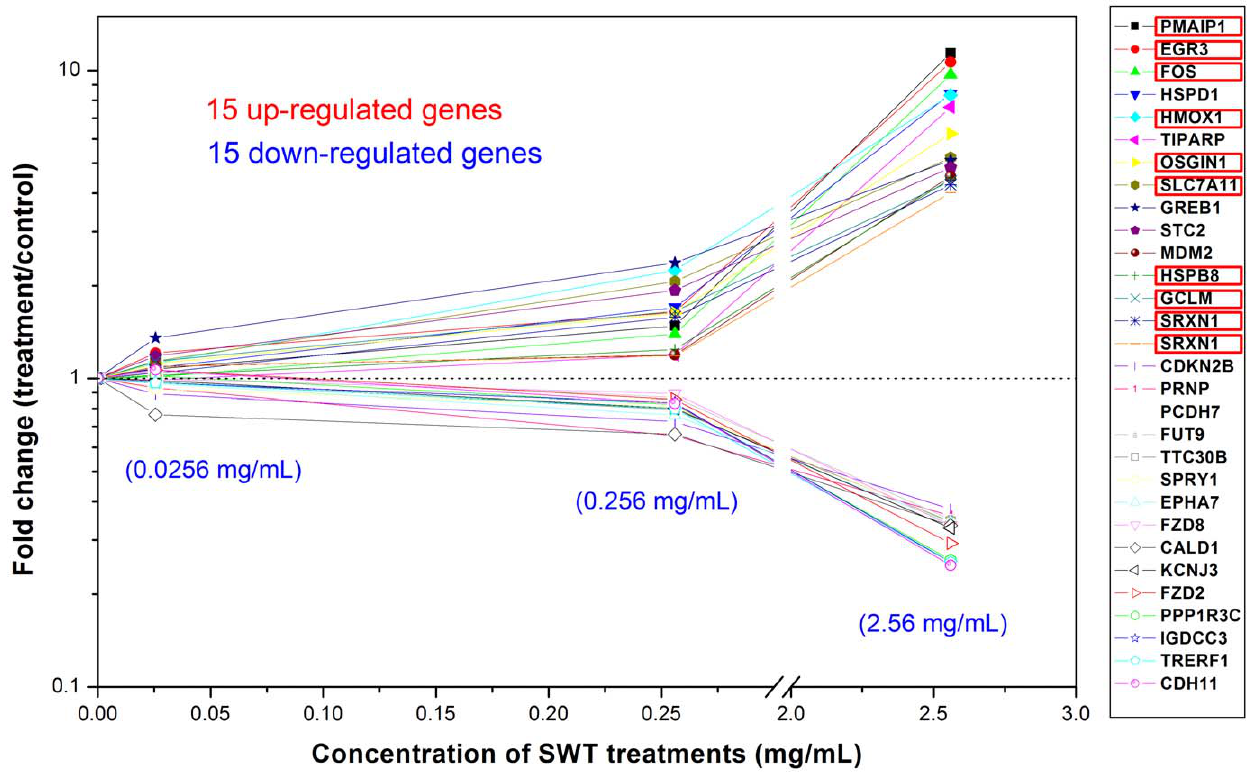
Figure 4. Dose-responsive genes with the largest fold changes. Among 15 dose-responsive up-regulated genes (probe sets) with the largest fold changes, ten are related to Nrf2 (highlighted in red box) according to PubMed literature search.